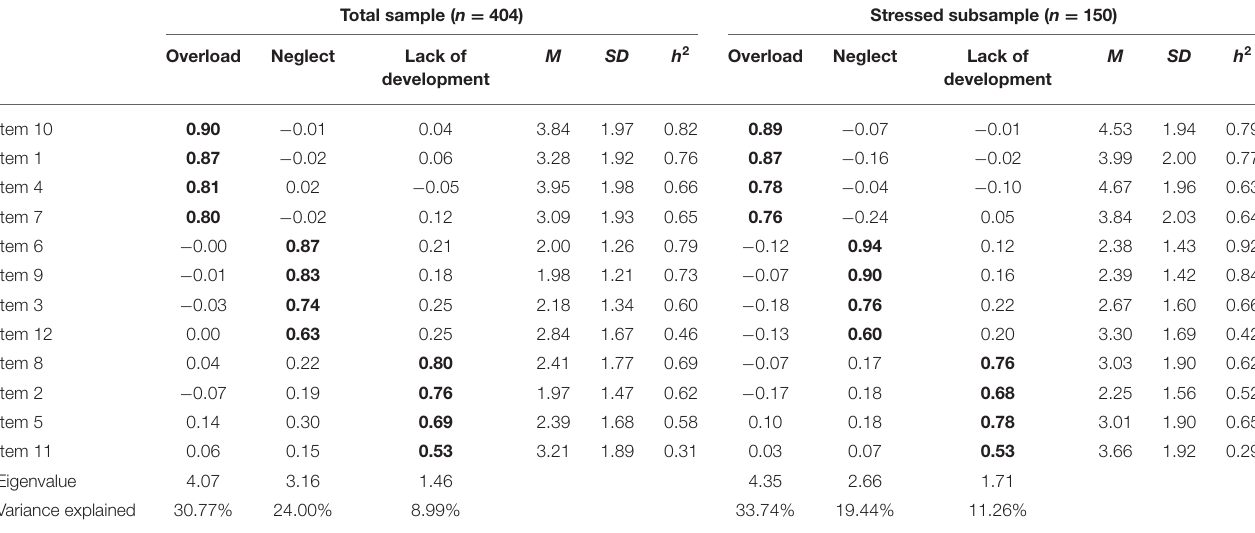
TABLE 2 | Exploratory factor analysis of the German BCSQ-12-SS.